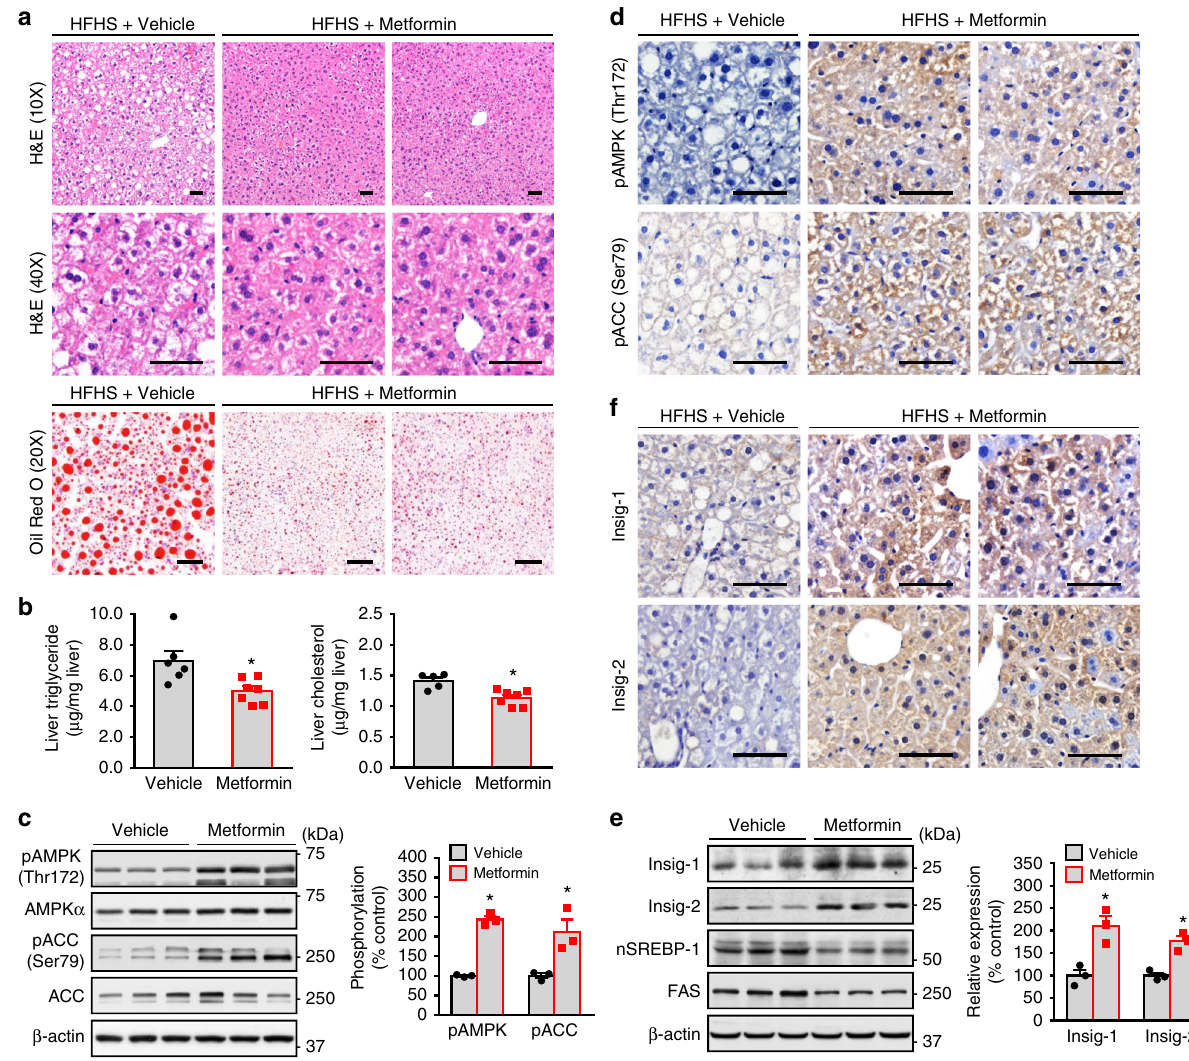
Fig. 1 Administration of metformin stimulates AMPK activity and increases Insig levels to attenuate hepatic steatosis in high-fat, high-sucrose diet-fed mice. Eight-week-old male C57BL/6 mice were fed with high-fat, high sucrose (HFHS) diet for 8 weeks, and then fed with HFHS diet supplemented with daily metformin (50 mg/kg/day) or vehicle (PBS) treatment via intraperitoneal injection for 8 weeks. a , b Metformin attenuates hepatic steatosis in HFHS diet-fed mice. a Representative H&E and oil red O staining of liver sections are shown (scale bar, 50 μ m). b Liver triglyceride and cholesterol levels were assessed. c , d AMPK activity is increased by metformin in the liver. c Immunoblots were performed, and the band intensity was quanti fi ed by densitometry. d Representative immunohistochemical staining of the liver sections with pAMPK and pACC antibodies. e , f The protein levels of Insig-1 and Insig-2 are increased in the liver of mice treated with metformin. e Immunoblots were performed, and the band intensity was quanti fi ed by densitometry. f Representative immunohistochemical staining of the liver sections with Insig-1 and Insig-2 antibodies. Scale bars, 50 μ m. Data are presented as the mean ± SEM, unpaired two-tailed Student ’ s t -test, n = 4 – 6, * p < 0.05, vs.